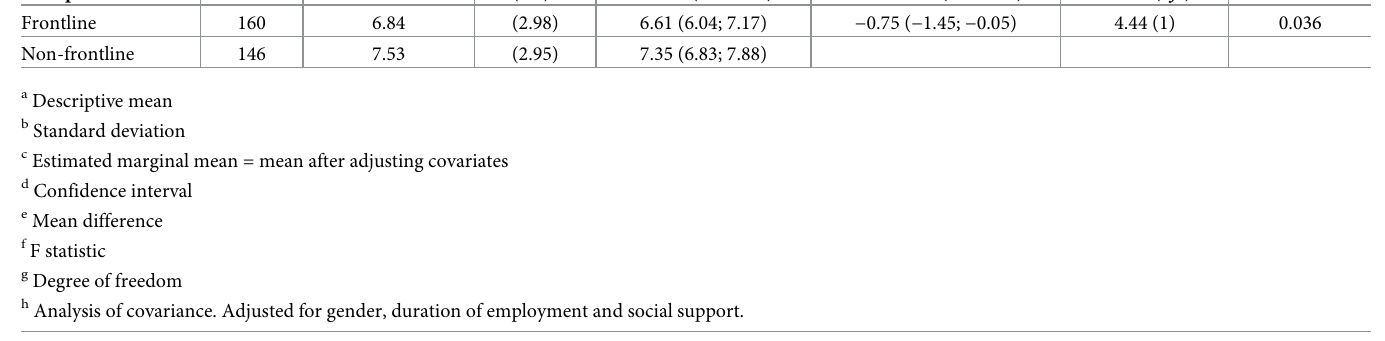
Table 3. Comparison of depressive symptoms levels between frontline and non-frontline healthcare providers.